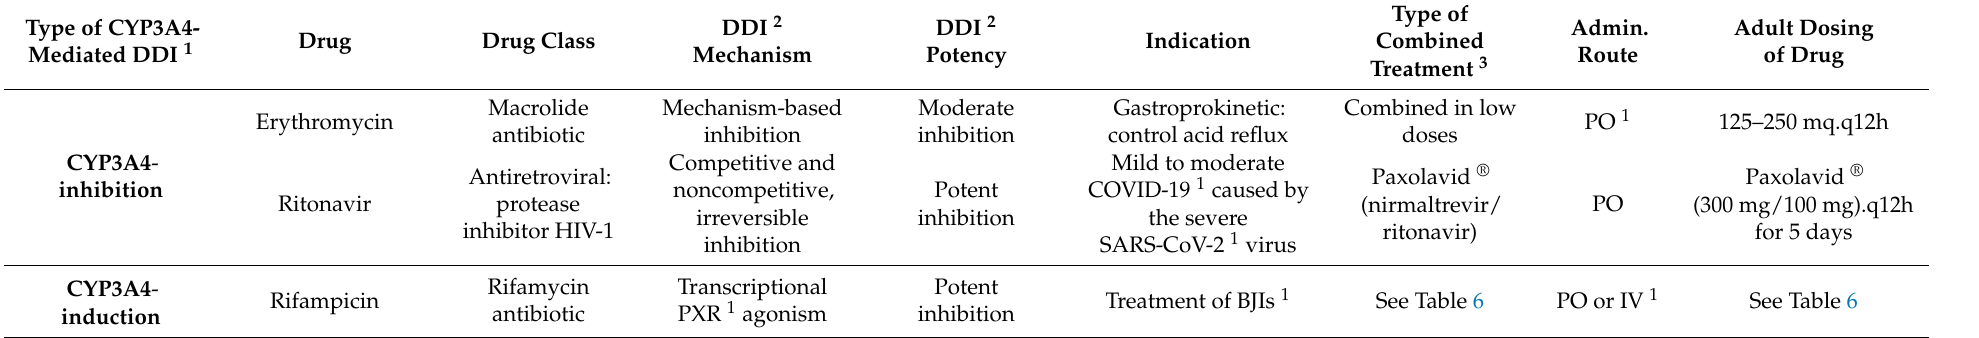
Table 7. CYP3A4-mediated drug–drug interactions arising from combined therapies with